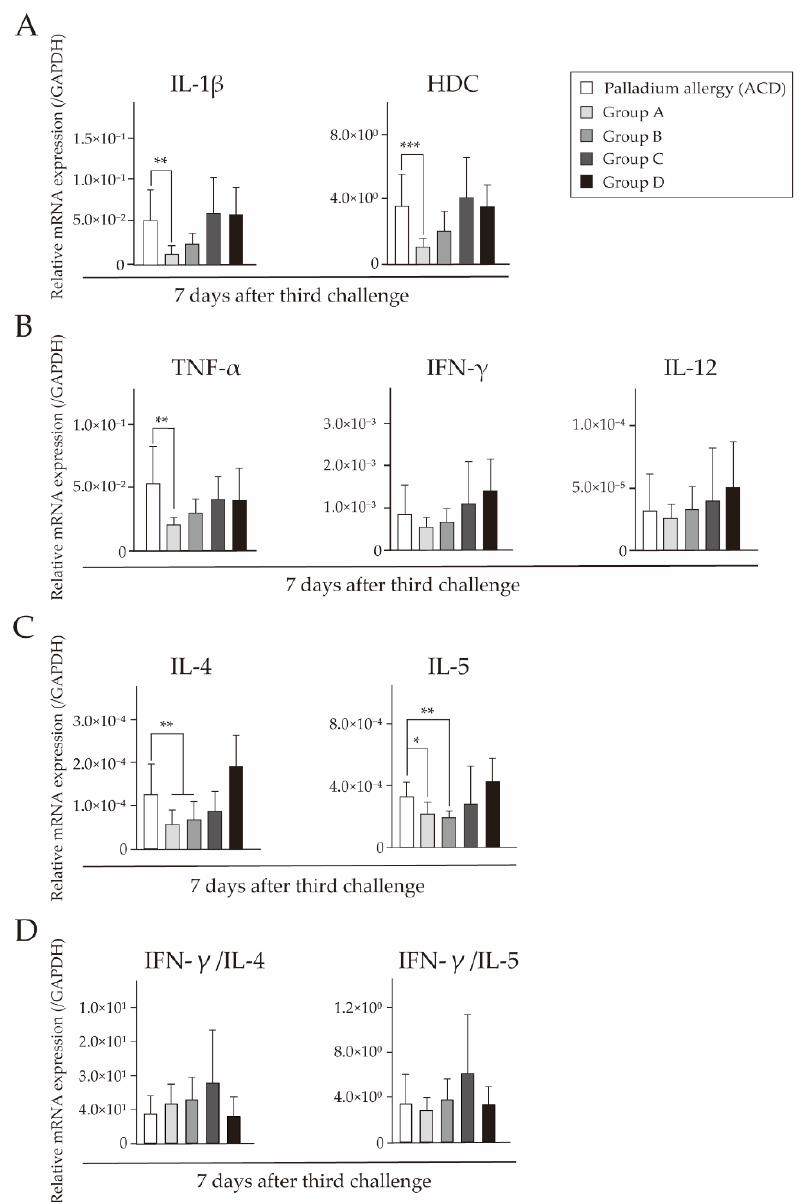
Figure 7. Effects of fexofenadine hydrochloride on the mRNA expression levels of T cell-related cytokines and chemokines in Pd-induced ACD mice. mRNA expression of ( A ) proinflammatory cytokine interleukin (IL) -1 β , Histidine decarboxylase (HDC), ( B ) T helper type (Th) 1 cytokines (tumor necrosis factor (TNF) - α , Interferon (IFN) - γ , and IL-12), ( C ) T helper type (Th) 2 cytokines (IL-4 and IL-5), and ( D ) Th1/Th2 cytokine imbalance (IFN- γ /IL-4 and IFN- γ /IL-5) are shown. GAPDH gene expression was used as an internal control. Bars and error bars indicate the mean + standard deviation (SD). Statistical significance was tested by the unpaired Mann Whitney test. * p <0.05 is considered as significant, ** p < 0.01 is considered as very significant, and *** p < 0.001 is considered as extremely significant. TNF: tumor necrosis factor; HDC: histidine decarboxylase; IFN: interferon; IL: interleukin.